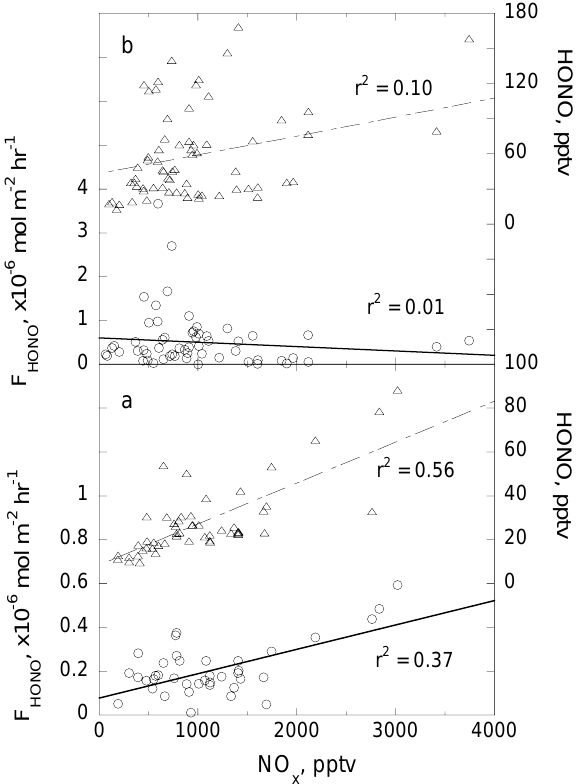
Fig. 7. Correlations between the HONO flux (left axis, open circles) and ambient NO x concentrations, and between ambient HONO (right axis, open triangles) and NO x concentrations during the night (22:00–06:00 EDT, (a) and during the day (08:00–18:00 EDT, (b) . The data are hourly averages, excluding the rain, fog and dew events. The lines are the least-square fits for the data.